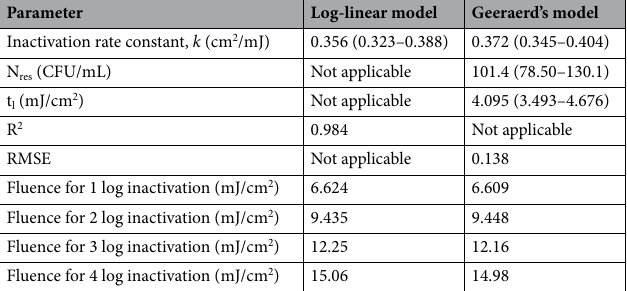
Table 1. Results of regression analysis using log-linear and Geeraerd’s models. Brackets contain 95% confidence intervals.